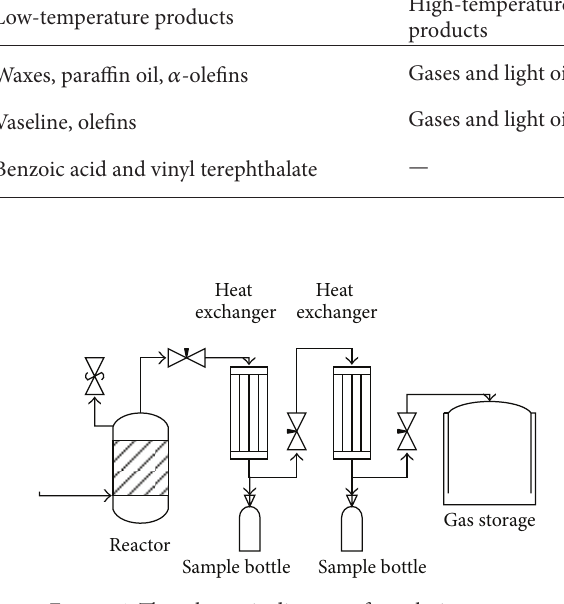
Table 1: The selected plastic wastes and their different thermal decompositions and products during pyrolysis process [1]. Resin